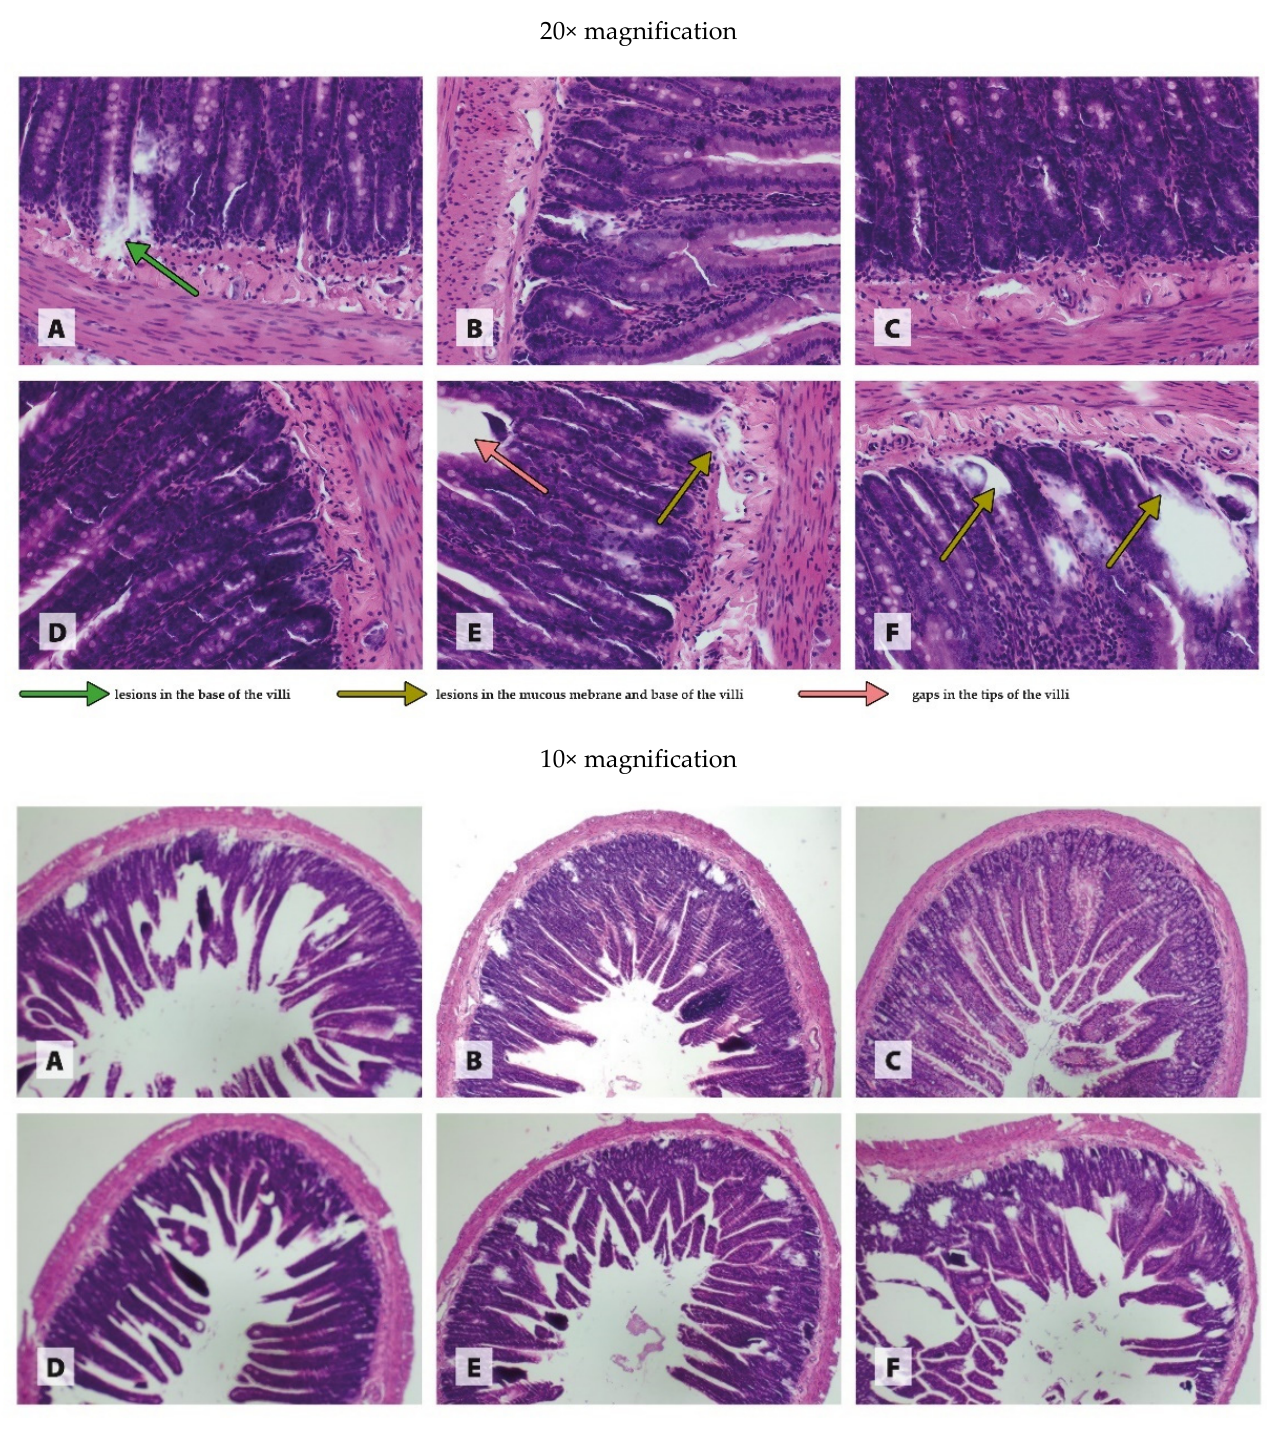
Figure 2. Morphological effects of different blood pressure and Cu sources on the small intestine of rats. Treatments: ( A ) WKY CuCO 3 6.5 , ( B ) WKY CuCO 3 3.25 + CuNP 3.25 , ( C ) WKY CuNP 6.5 , ( D ) SHR CuCO 3 6.5 , ( E ) SHR CuCO 3 3.25 + CuNP 3.25 , and ( F ) SHR CuNP 6.5.